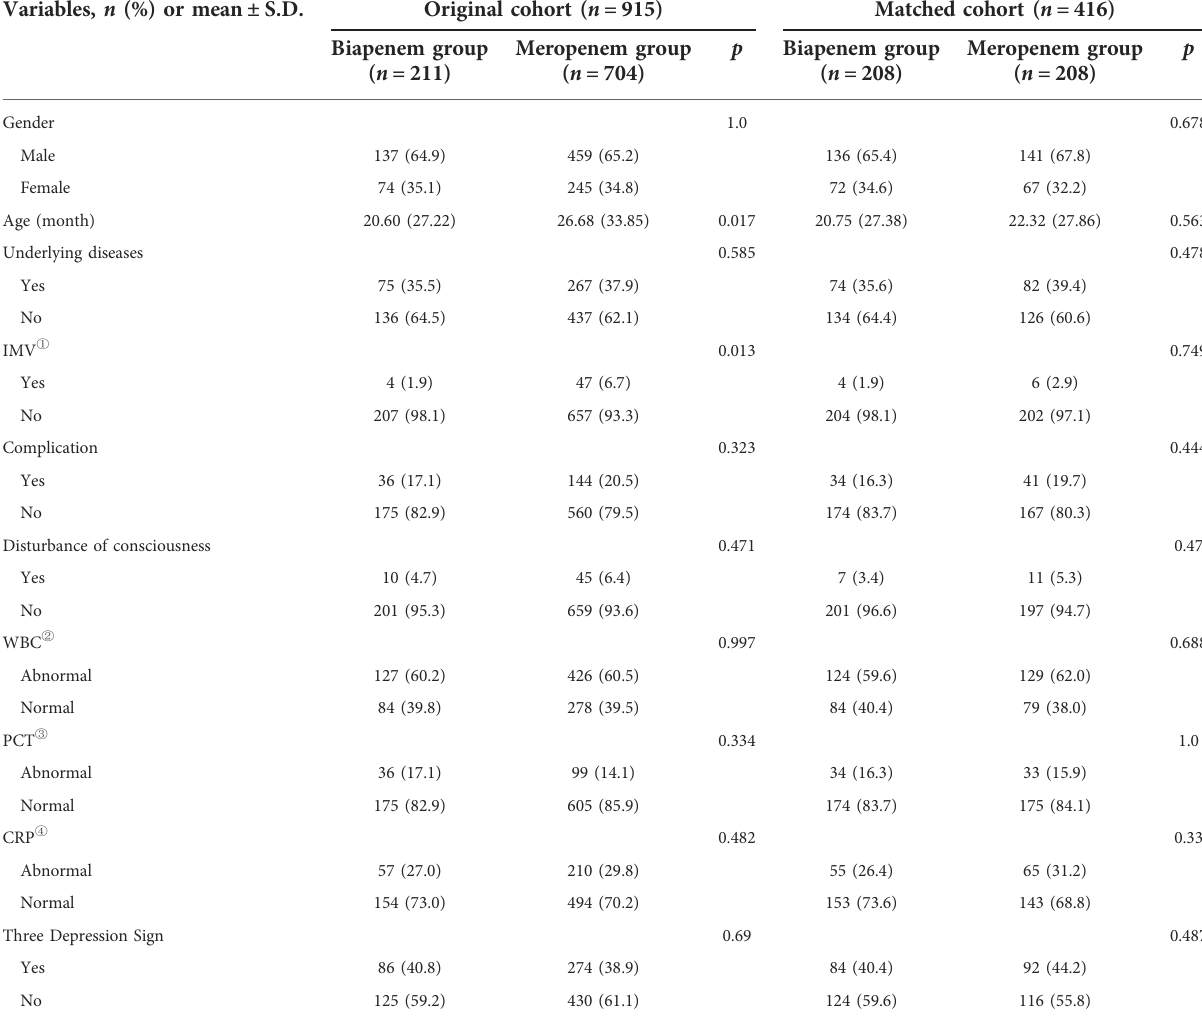
TABLE 1 Comparison of baseline data between Biapenem group and Meropenem group before and after matching. Variables, n (%) or mean ±